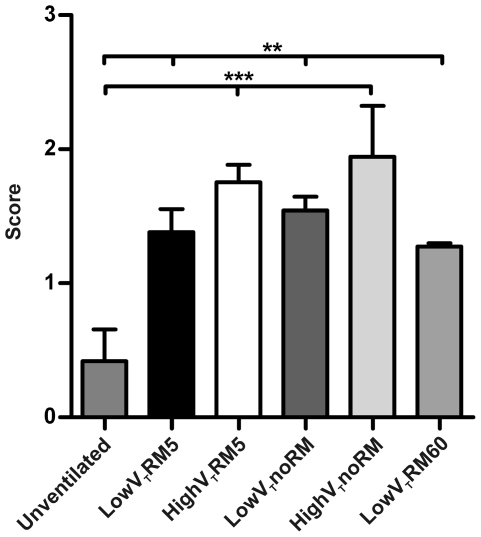
Histopathological scoring.Scoring criteria were: neutrophils in the alveolar or interstitial space, alveolar septal thickening, alveolar congestion and formation of hyaline membranes. Scores from 0 to 4 were given according to the number of fulfilled criteria. (Unventilated: n = 5, lowVTRM5 n = 5, highVTRM5 n = 5, lowVTnoRM n = 4, highVTnoRM n = 4, lowVTRM60 n = 5). ** p<0.01, *** p<0.001.